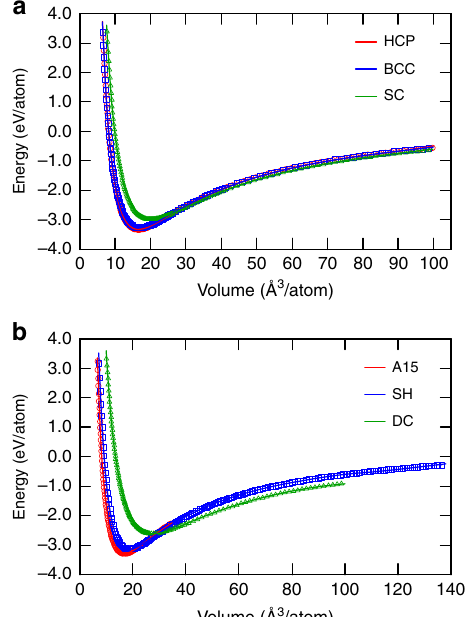
Fig. 5 Energy – volume relations for Al crystal structures. Comparison of the energies predicted by the PINN potential (lines) and by DFT calculations (points). a Hexagonal close-packed (HCP), body-centered cubic (BCC), and simple cubic (SC) structures. b A15 (Cr 3 Si prototype), simple hexagonal (SH), and diamond cubic (DC)